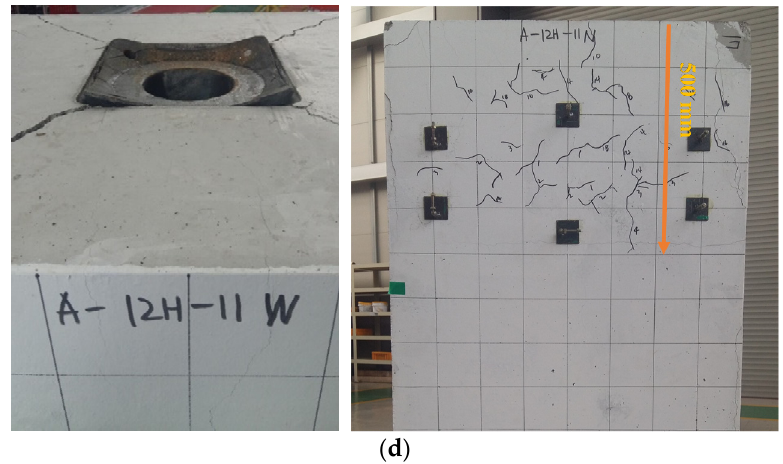
Figure 11. Fracture mode of group 3 specimens: ( a ) A12H-8; ( b ) A12H-9; ( c ) A12H-10; ( d ) A12H-11.